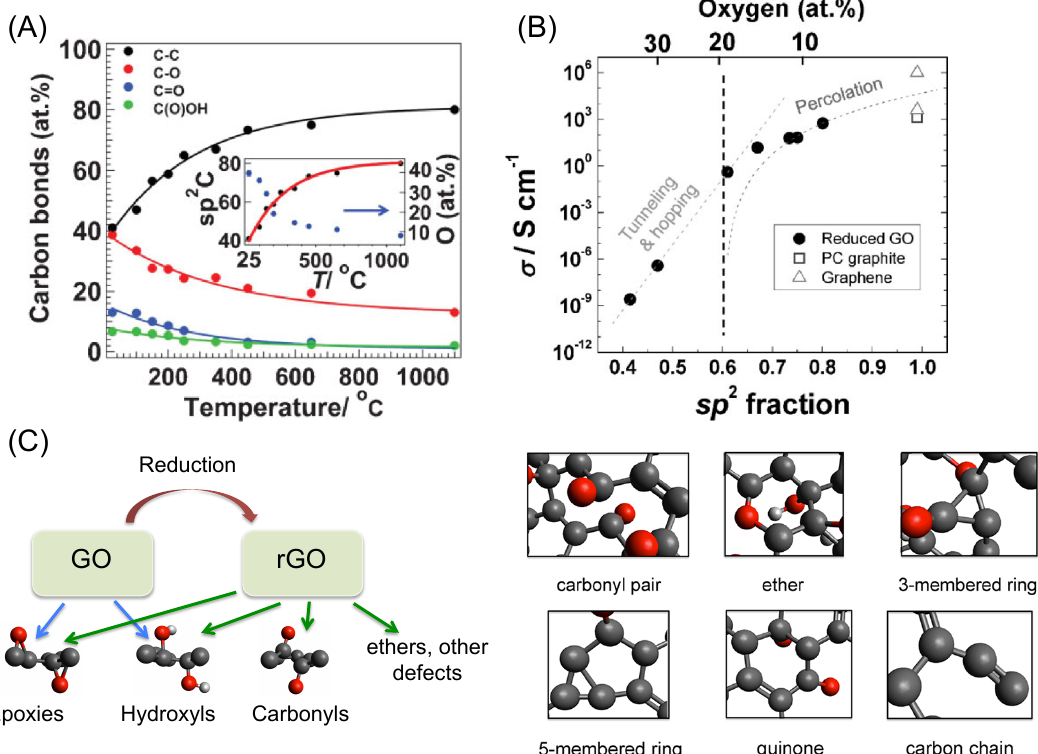
Figure 1. (a) Schematic of the preparation protocol of rGO. (b) Representative disordered carbonyl-rich rGO structure. Carbon, oxygen, and hydrogen are represented as gray, red, and white spheres, respectively. (c) Various groups and defects formed during high temperature reduction of GO by conversion of initial epoxy and hydroxyl groups. (d) Average fraction of oxygen-containing functional groups as a function of average fi nal oxygen concentration in the rGO sheets, for di ff erent initial GO structures with epoxy to hydroxyl ratios of 3:2 (left) and 2:3 (right). The thermal reduction of these two cases results in, respectively, carbonyl-rich rGO (left) and hydroxyl-rich rGO (right). In each plot, the results are obtained by averaging over 40 rGO structures, and the error shown represents the standard error of the mean calculated for the same set of structures. Figure 2. ( A ) Evolution of sp 2 C=C carbon and different oxygen functionalities at different annealing temperatures. The inset correlates the total oxygen concentration with the sp 2 C=C content at different reduction temperatures. ( B ) Conductivity of rGO thin films as a function of the sp 2 C=C content/oxygen content. ( C ) Dominant oxygen functional groups present in GO and rGO, along with close-ups of various other oxygen groups and defects that are created upon reduction of GO. Figures reproduced (cid:13) with permission from: ( A , B ) [23], Wiley c